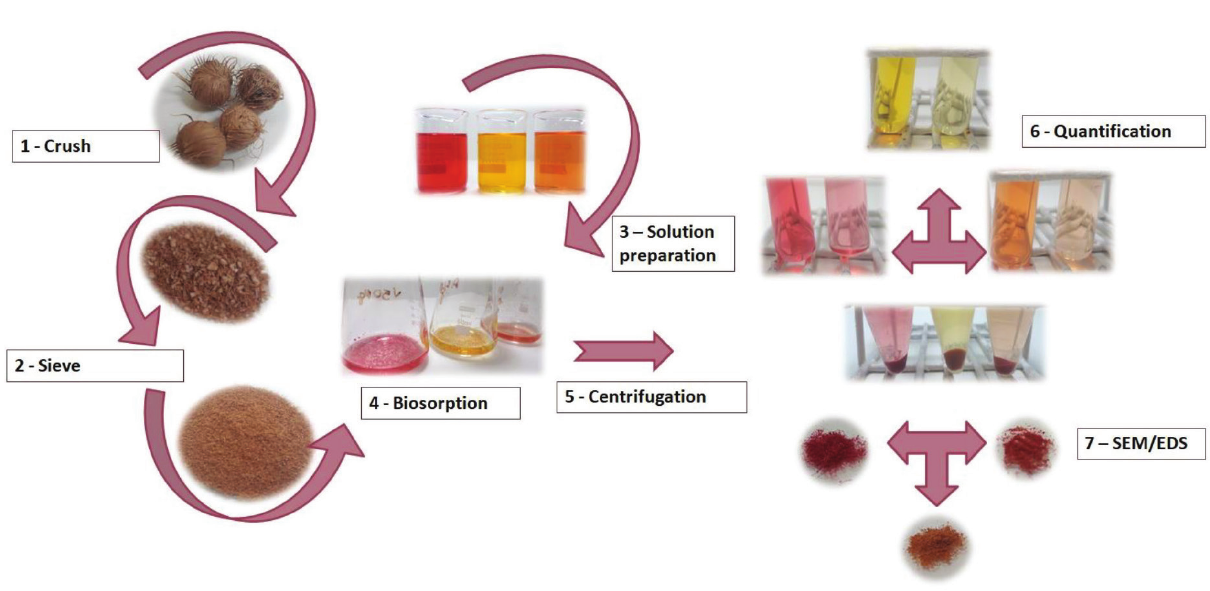
Fig. 1 – Experimental procedure: detailed steps of dye biosorption in Açaí